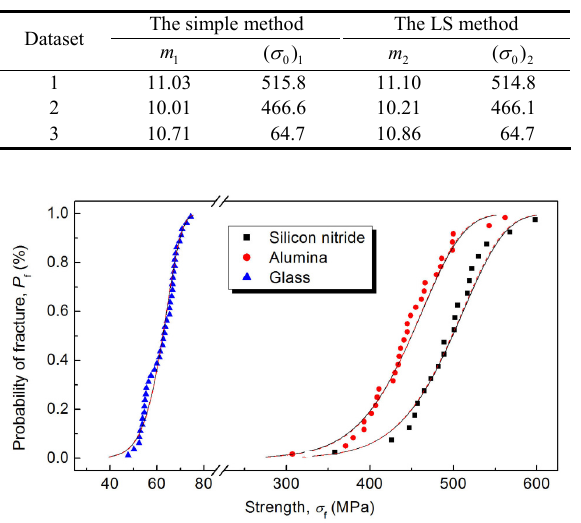
Fig. 12 Weibull graphs of the measured strength for Si 3 N 4 , Al 2 O 3 , and glass. Solid lines and dashed lines are obtained by the simple method and the LS method,